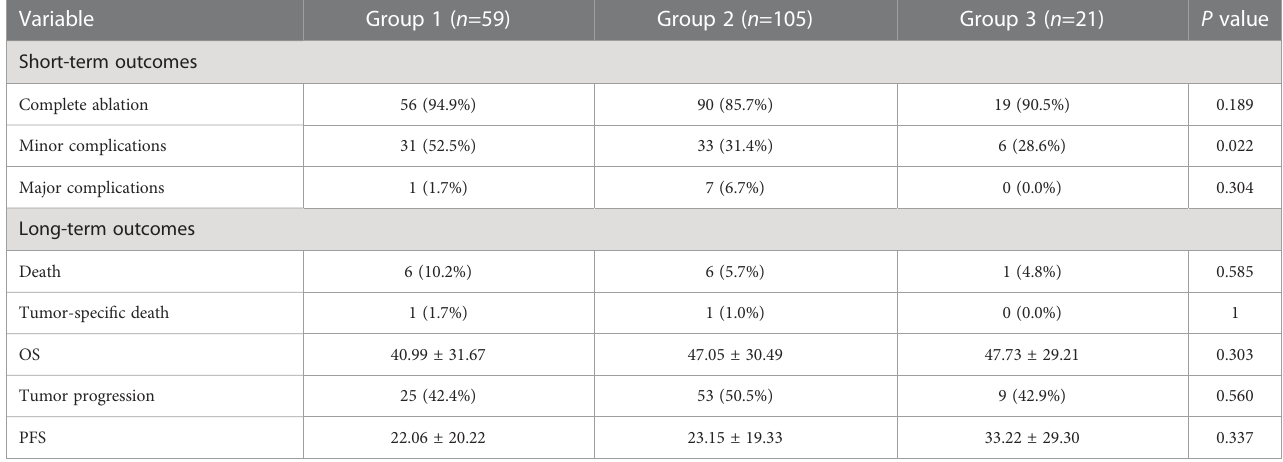
TABLE 2 Prognostic outcomes for groups 1 –